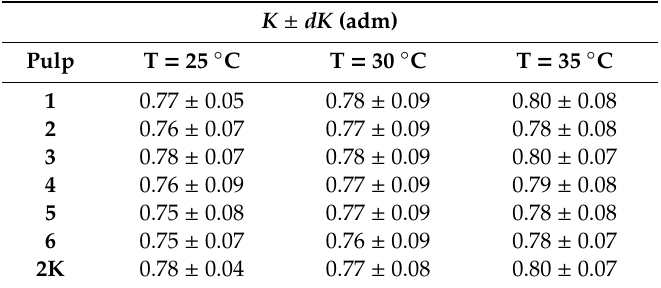
Table 6. Energy parameter K . at 25, 30, and 35 ◦ C.